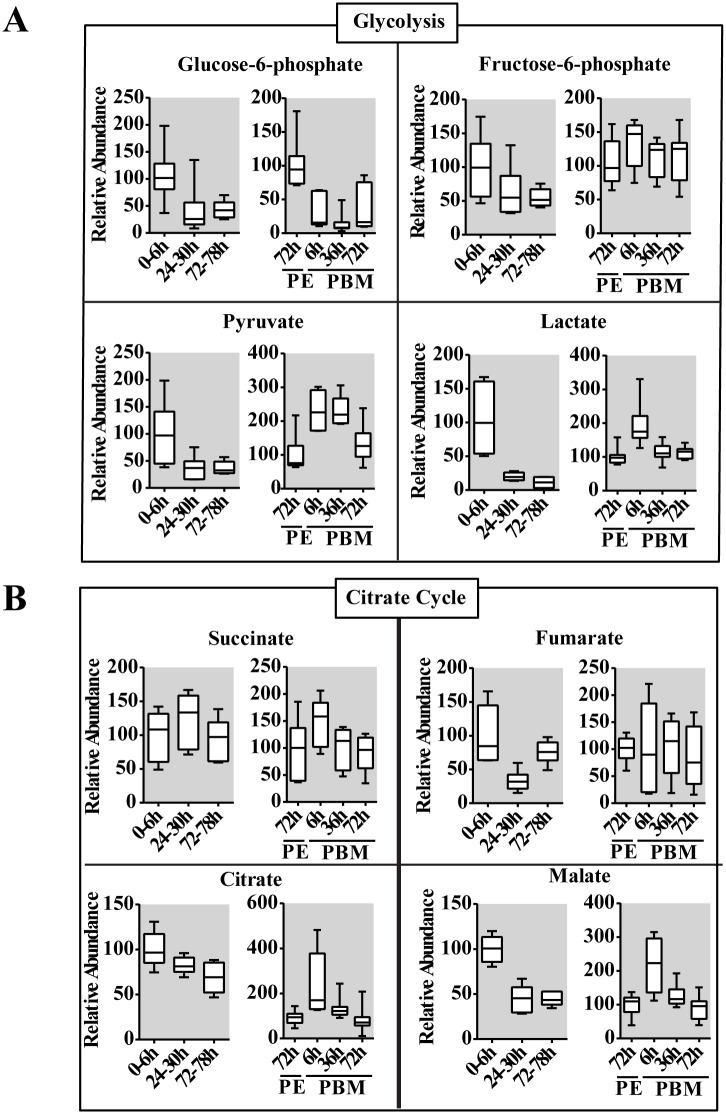
Changes in the level of intermediary metabolites throughout the reproductive cycle of adult female mosquito.(A and B) Relative levels for intermediary metabolites of glycolysis (A) and the citrate cycle (B) during PE and PBM development. Glucose-6-phosphate, fructose-6-phosphate, pyruvate and lactate from the glycolytic pathway, and citrate, succinate fumarate and malate from the citrate cycle were measured using gas chromatography—mass spectrometry (GC/MS). The time points 0-6h PE and 72h PE were used as controls for PE and PBM periods, respectively. The controls are represented as relative abundance 100, and the levels at other time points were adjusted accordingly. In the box plots, the box represents the lower and upper quartiles, the horizontal line represents the median and the bars represent the minimum and maximum data points (n = 12 samples collected from independent populations, with six adult female mosquito per sample). Three independent sets of metabolite measurements were performed with similar results.